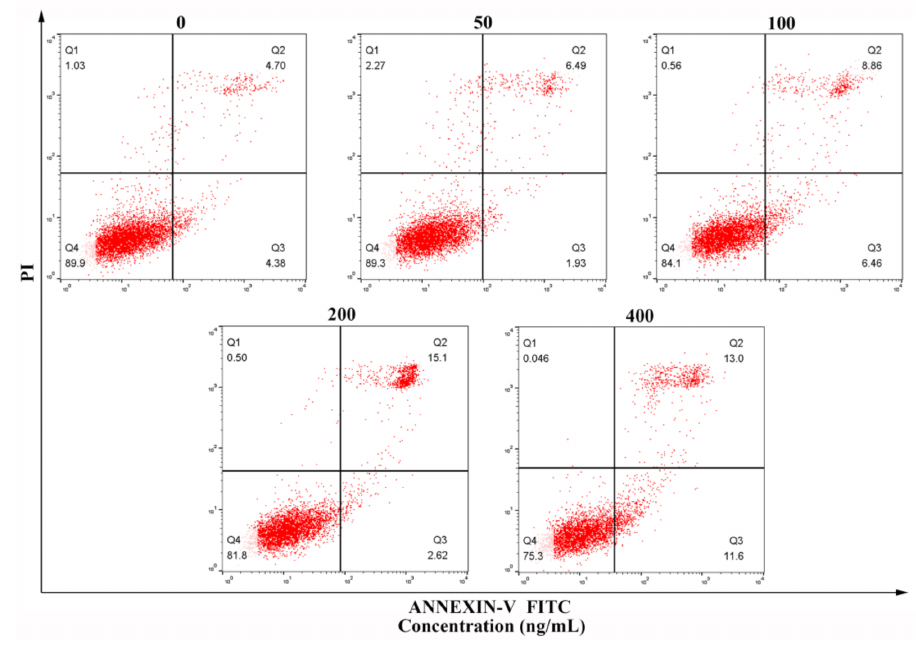
Figure 6. Flow cytometry detection of